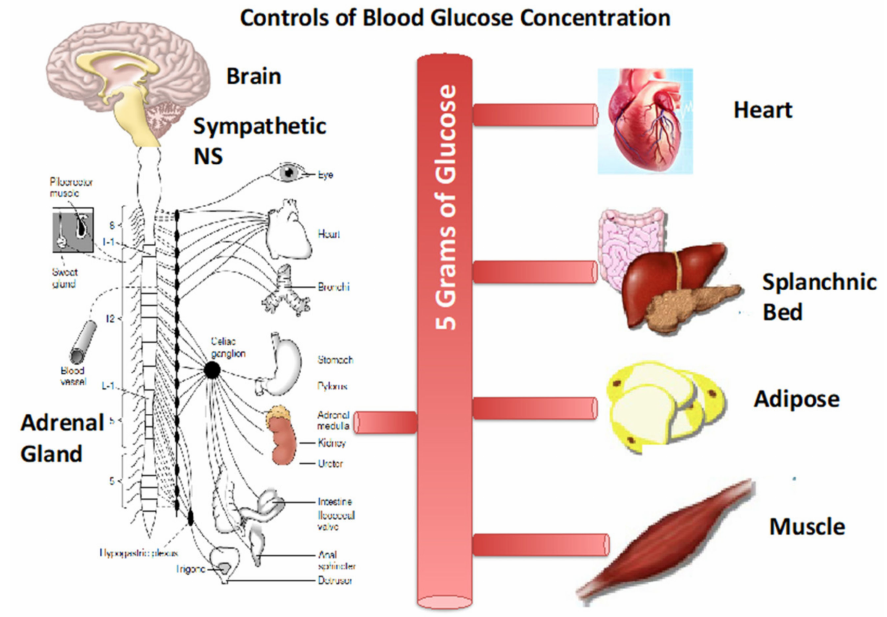
Figure 12. A mere 5 g, a teaspoon, of blood sugar (glucose) is regulated by a coordinated set of neuroendocrine responses involving both feed-forward and feedback components. For exercise the responses involve the sympathetic nervous system (SNS) and its capabilities via post-ganglionic nerves that release norepinephrine and the adrenal medulla that releases epinephrine for direct and endocrine signaling that initiate cardiopulmonary, cardiovascular, and other fight and flight autonomic responses. Cardiovascular control serves to direct the limited glucose supply where it is needed (heart, brain, working skeletal muscle), and shunt blood flow and glucose delivery away from other tissues. In the splanchnic bed the pancreas secretes insulin ( β -cells), glucagon ( α -cells), and somatostatin ( δ -cells). As well, gastric secretion of ghrelin, GLP-1, and PYY a ff ect appetite and eating behavior that provides major support of glycemia. Feedback control includes the Metaboreflex, secretion of myokines (e.g., IL-6) and lactate from working muscle, and changes in blood (glucose), as well as epinephrine from the adrenal medulla that inhibits pancreatic secretions. In adipose lipolysis is inhibited by lactate via c-AMP and CREB as well as TGF- β 2 released from liver under the influence of circulating lactate. See text for details. Figure modified from [1] and other sources including